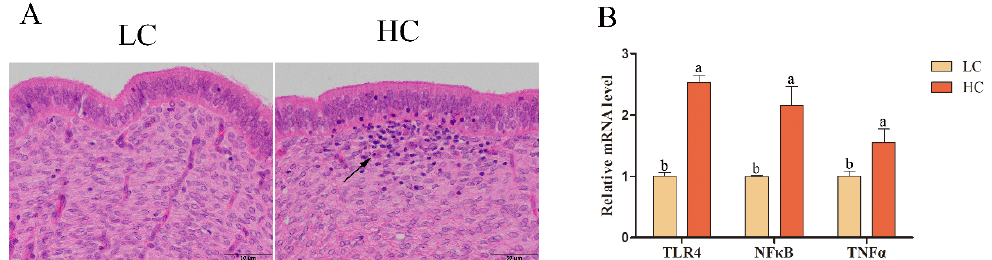
Figure 2. Hematoxylin-eosin staining of sheep uterine tissue sections in the LC and HC groups and relative mRNA expression levels of TLR4 , NF κ B , and TNF α . The arrows show inflammatory cells. ( A ) Hematoxylin-eosin staining. Original magnification, 400×. ( B ) Relative mRNA expression levels of TLR4 , NF κ B , and TNF α . Different lowercase letters indicate a significant difference at p < 0.05.